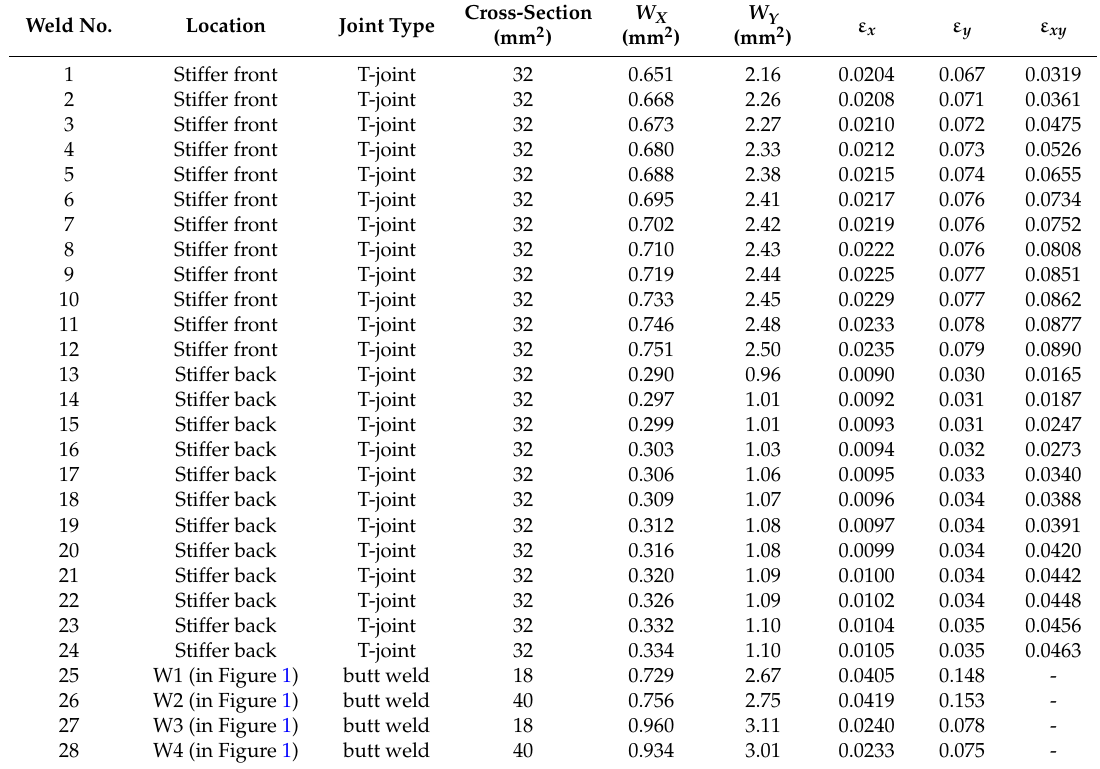
Figure 7. Heat expansion coefficient transfer of the fillet welding. Table 4. Inherent strain on each weld joints.